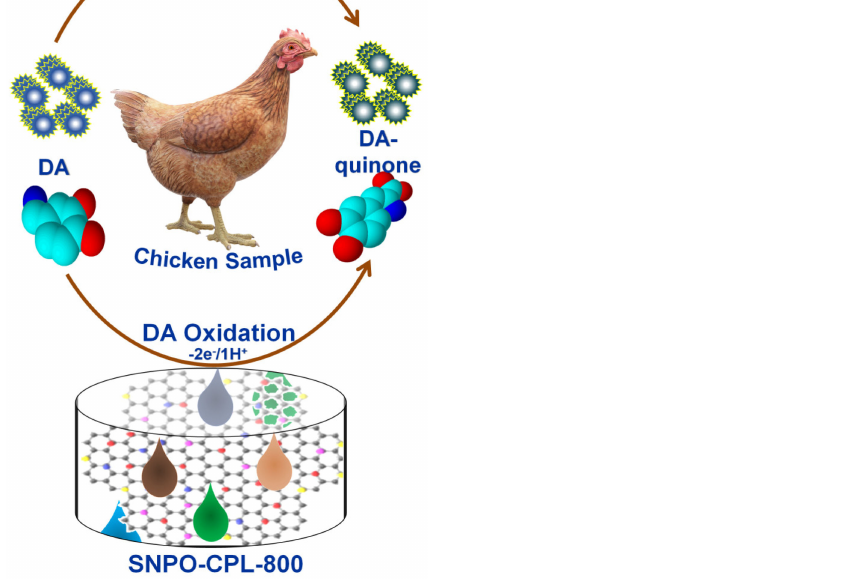
Scheme 2. Schematic illustrations showing the oxidation of DA at the surface of